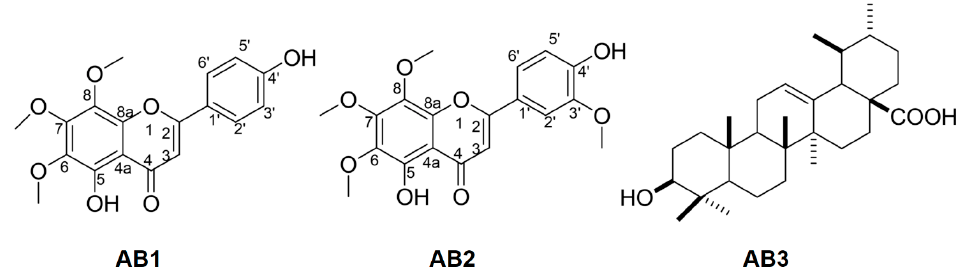
Figure 3. Chemical structures of AB1, AB2 and AB3.